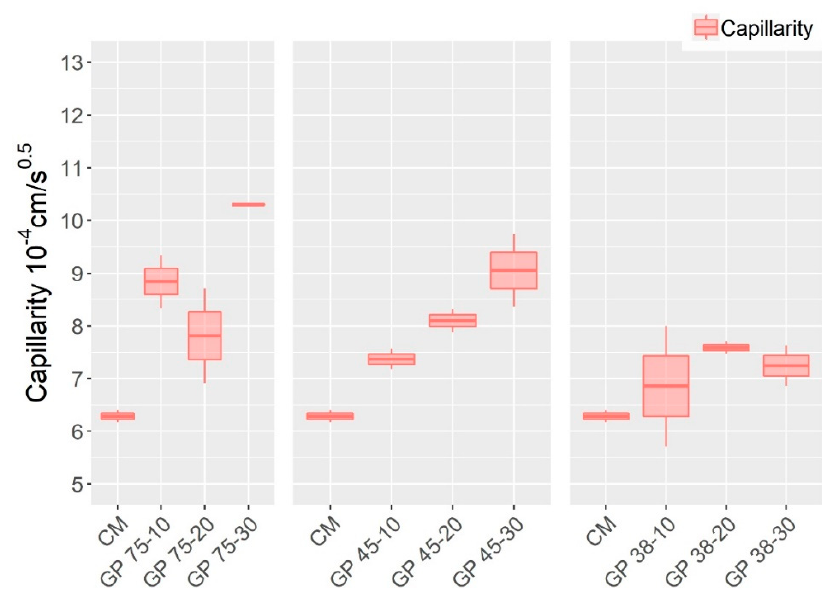
Figure 5. Capillarity results for mortar samples.